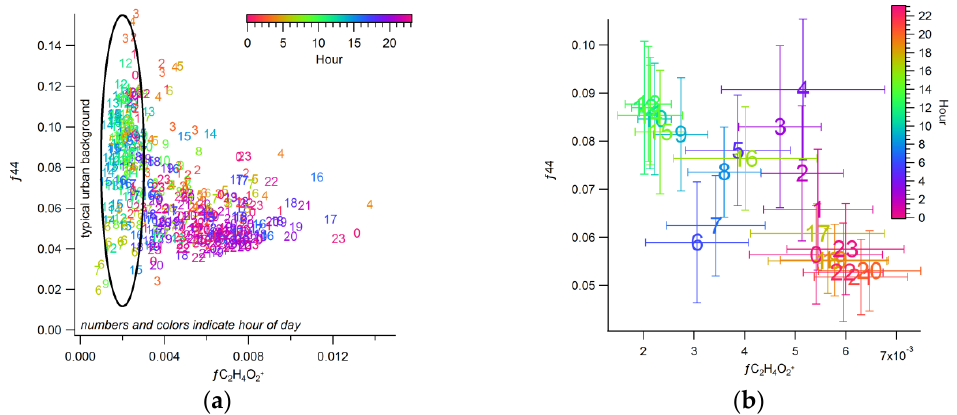
Figure 4. Scatter plot of the fraction of OM from m / z 44 and C 2 H 4 O 2+ , with color and numbers indicating hour of the day, for: ( a ) all data (hourly averages); and ( b ) data averaged by hour during the study.